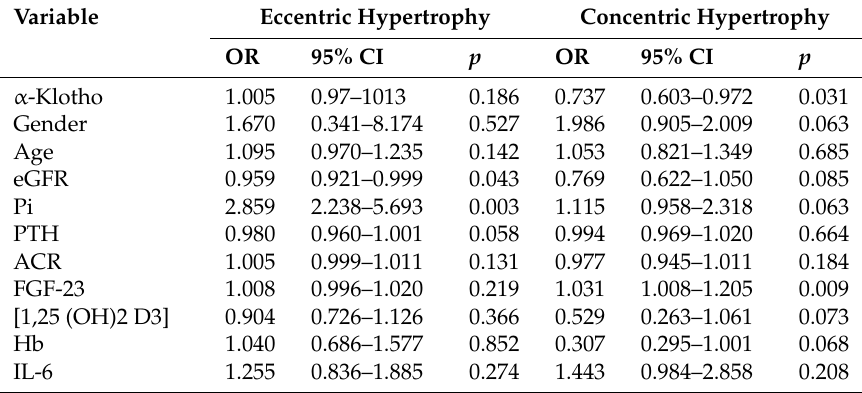
Table 4. Clinical characteristics’ correlation with eccentric or concentric left ventricular hypertrophy by multinomial logistic regression analysis.